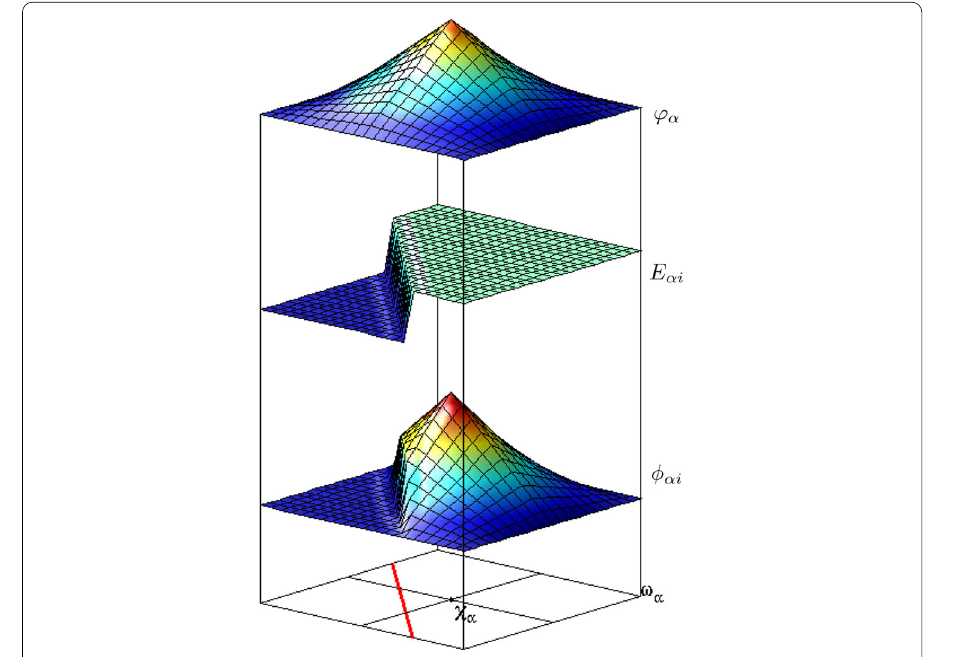
Fig. 2 GFEM Heaviside shape function graphic. This figure presents a partition of unity function ϕ α , enrichment function E α i and resulting GFEM shape function φ α